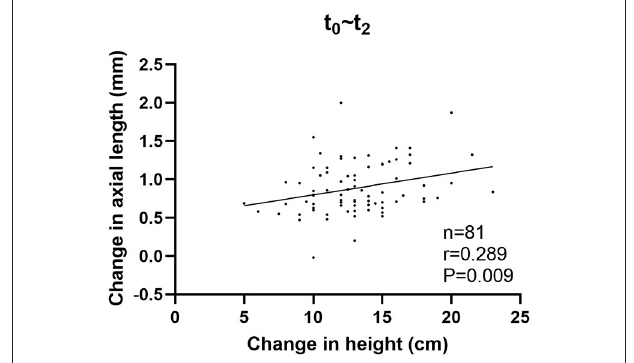
FIGURE 4 | Correlation between changes in height and changes in axial length in the newly developed myopia group after the onset of myopia.